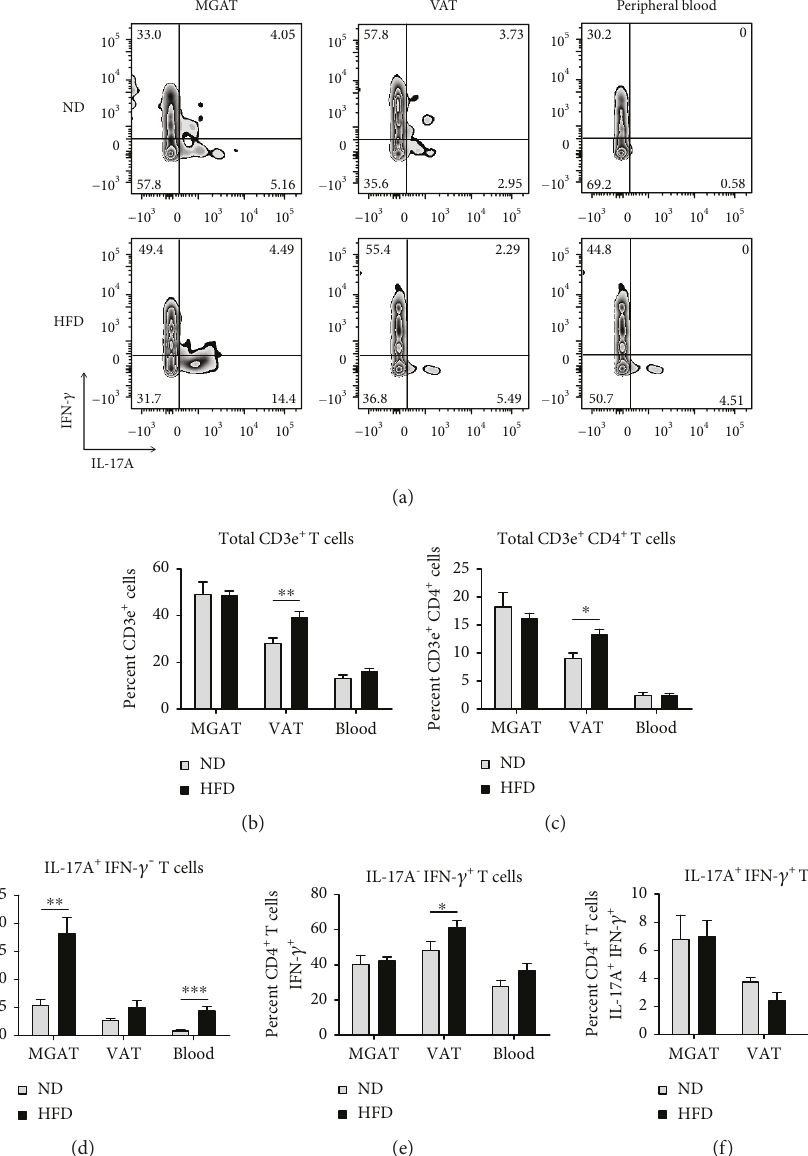
Figure 3: Increased percentage of CD4 + T cells express IL-17A in MGAT and blood of preobese mice compared to CD4 + T cells in MGAT and blood of lean control mice. (a) Flow cytometric analysis of a representative mouse from each group, showing IL-17A and IFN- γ cytokine expression in CD3e + CD4 + T cell populations from MGAT, visceral adipose tissue (VAT), and peripheral blood (PB) of HFD- and ND-fed C57BL/6 mice at endpoint (9 weeks of postinitiation of diet). Cells were stimulated with PMA/ionomycin cocktail + protein transport inhibitor for 5h at 37 ° C prior to fi xation, permeabilization, and staining. For fl ow cytometric analysis of cytokine expression, cells were fi rst gated on single, live, CD3e + , and CD4 + T cell populations (Figure S4). (b – f) Graphical representation of the percentage of total CD3e + T cells, total CD3e + CD4 + T cells, IL-17A + CD4 + T cells, IFN- γ + CD4 + T cells, and IL-17A + IFN- γ + CD4 + T cells in MGAT,